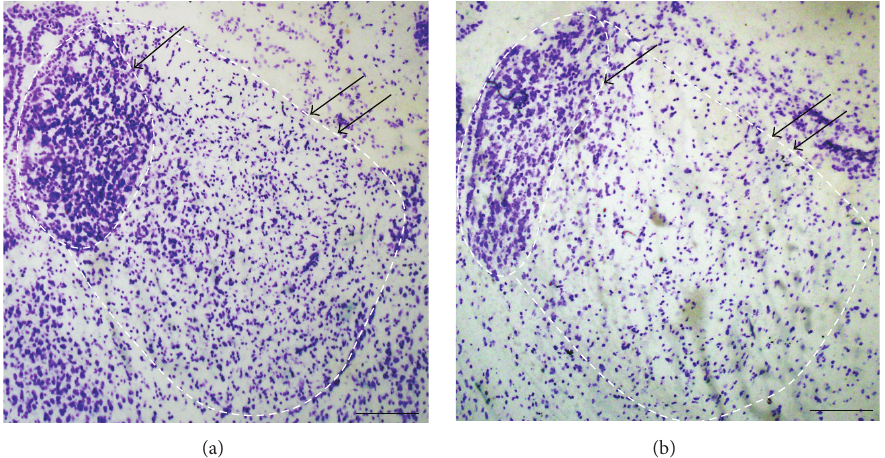
Figure 1: A crystal violet staining photomicrograph of LHb lesion. (a) showed the normal Hb and (b) showed the lesion of LHb. The single arrow identifies the MHb, whereas the double arrows identify the LHb. Scale bars represent 100 𝜇